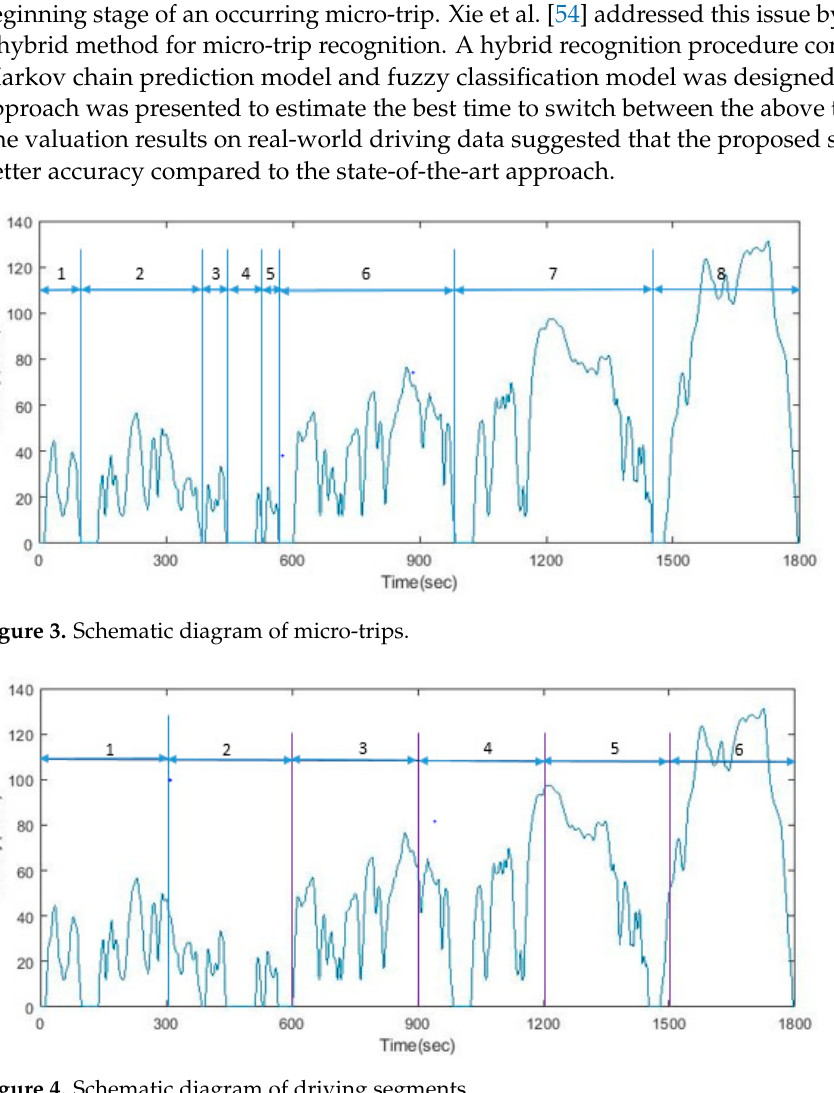
Figure 4. Schematic diagram of driving segments.